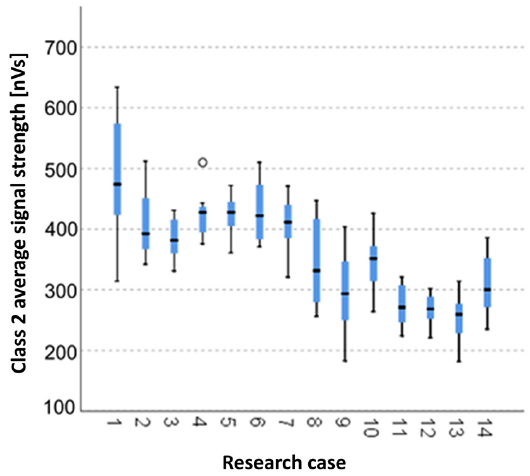
Figure 20. The graphical representation of the Kruskal–Wallis test results for independent samples of the average signal strength of the class 2